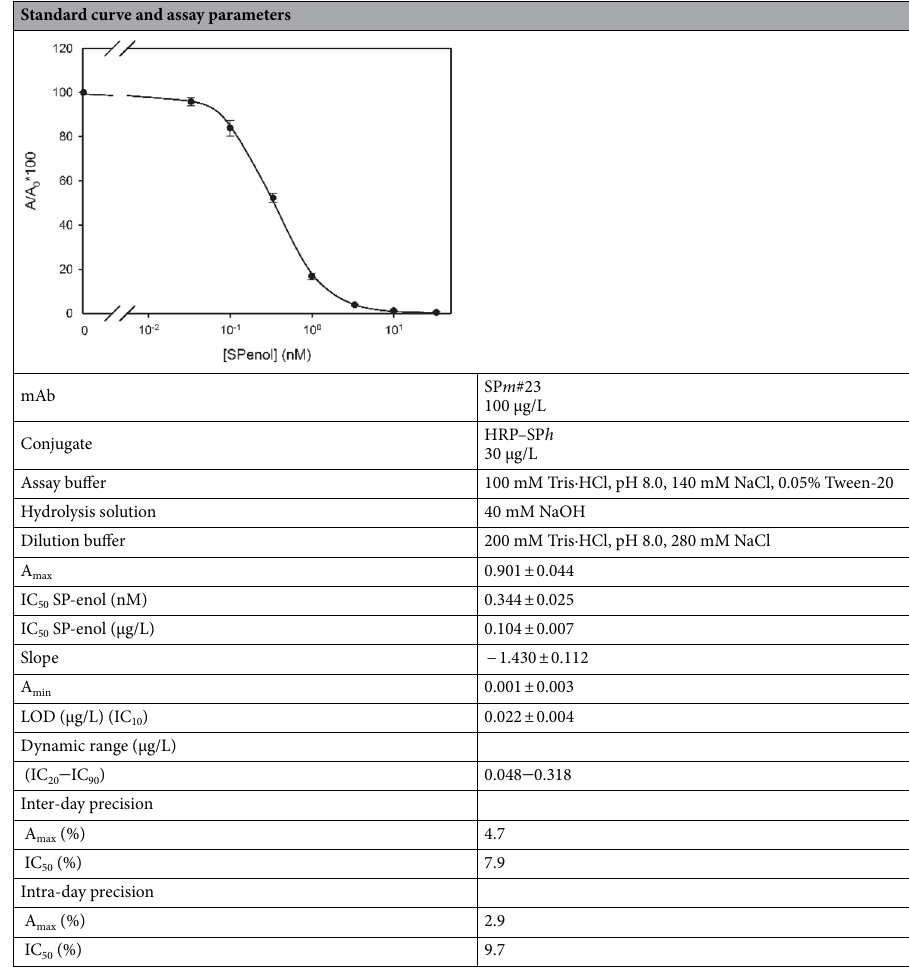
Table 3. Assay conditions and analytical parameters of the optimized immunoassay (n =